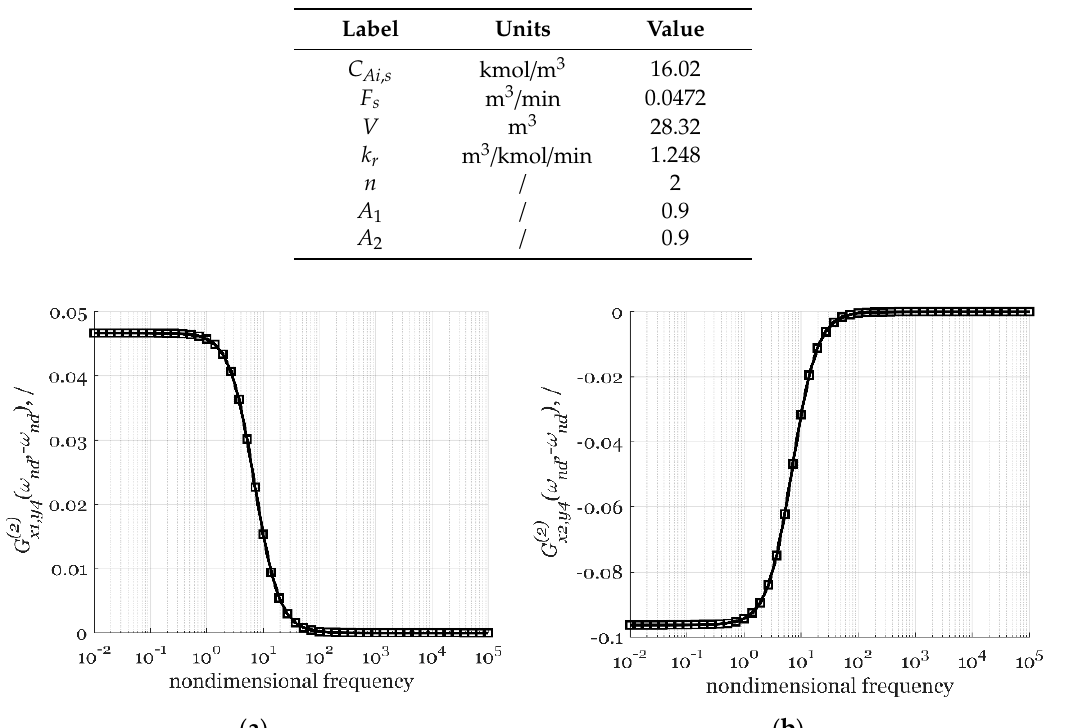
Table 1. Values of parameters and constants used for simulation in Example 1: CSTR.